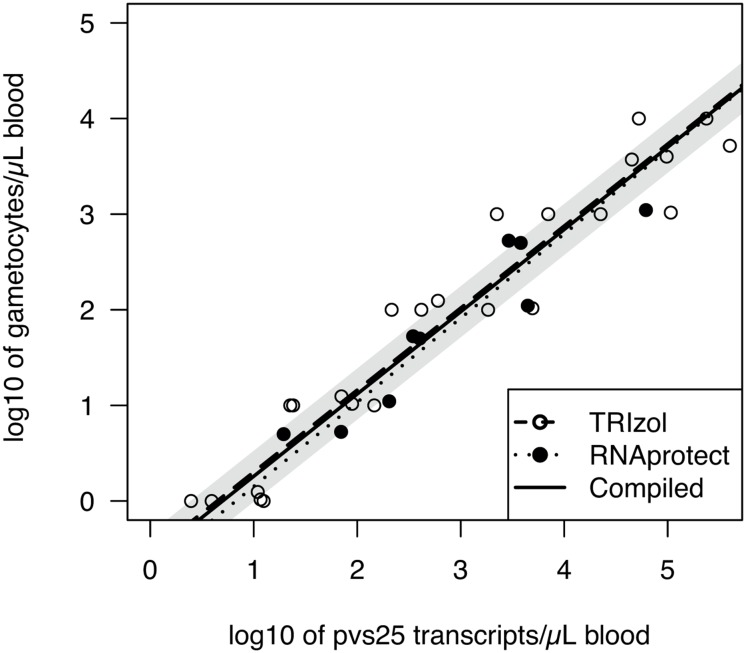
Relationship between parasite density and probability that a sample is gametocyte positive.Left: Probability (with CI95) that a sample is gametocyte positive vs. parasite density, calculated using a general additive model. Right: correlation between gametocyte density (measured as pfs25 or pvs25 transcripts/uL) and parasite density by qPCR.